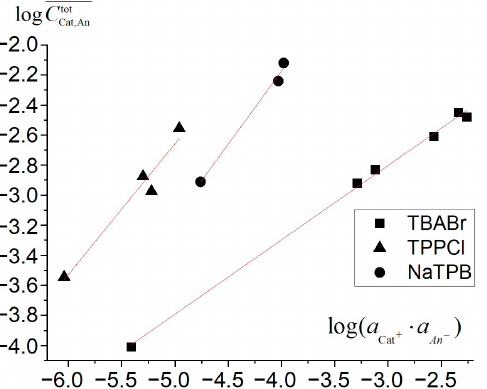
Figure 1. The bi-logarithmic dependences of total salt concentrations in the membrane phase upon electrolyte activity in the solution. The fitted lines are as follows: y = 0.495x − 1.273 for TBABr; y = 0.87x + 1.74 for TPPCl; y = 0.97x + 1.75 for NaTPB.